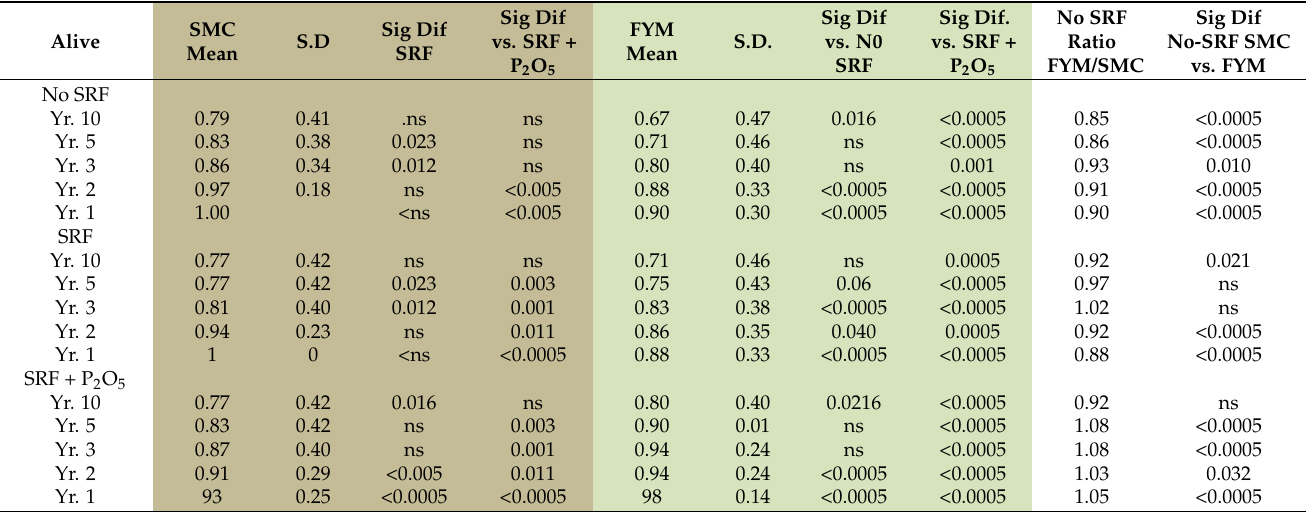
Table 5. Survival of SMC- and FYM-stands with fertilizer supplement variants (i.e., SMC-planted and FYM-planted trees) given no SRF, SRF or SRF + P 2 O 5